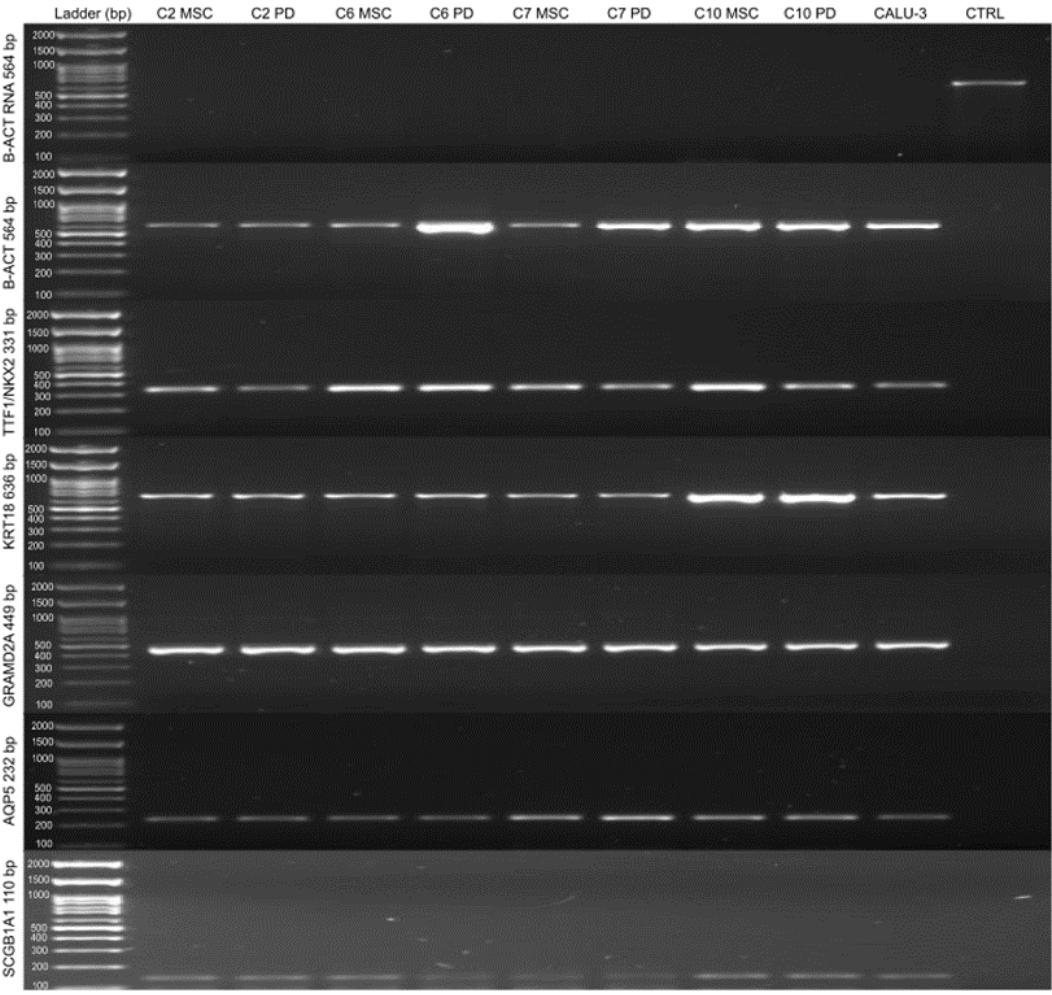
Figure 6. RT-PCR for lung cell genes. RT-PCR for B-ACT (564 bp) in a DNAse-treated RNA sample, B-ACT (564 bp) in a cDNA sample, TTF1/NKX2.1 (331 bp), KRT18 (636 bp), GRAMD2A (449 bp), AQP5 (232 bp), and SCGB1A1 (110 bp) genes, respectively, from top to bottom. RT-PCR was performed in four samples (C2, C6, C7, and C10), both undifferentiated (CT) and after lung differentiation (DP); as a positive control, the Calu-3 cell lineage was used, and as a negative control, a reac- tion was performed without addition of DNA. The molecular weights range from 100 bp to 2000 bp; from 100 to 1000, each hundred is indicated.